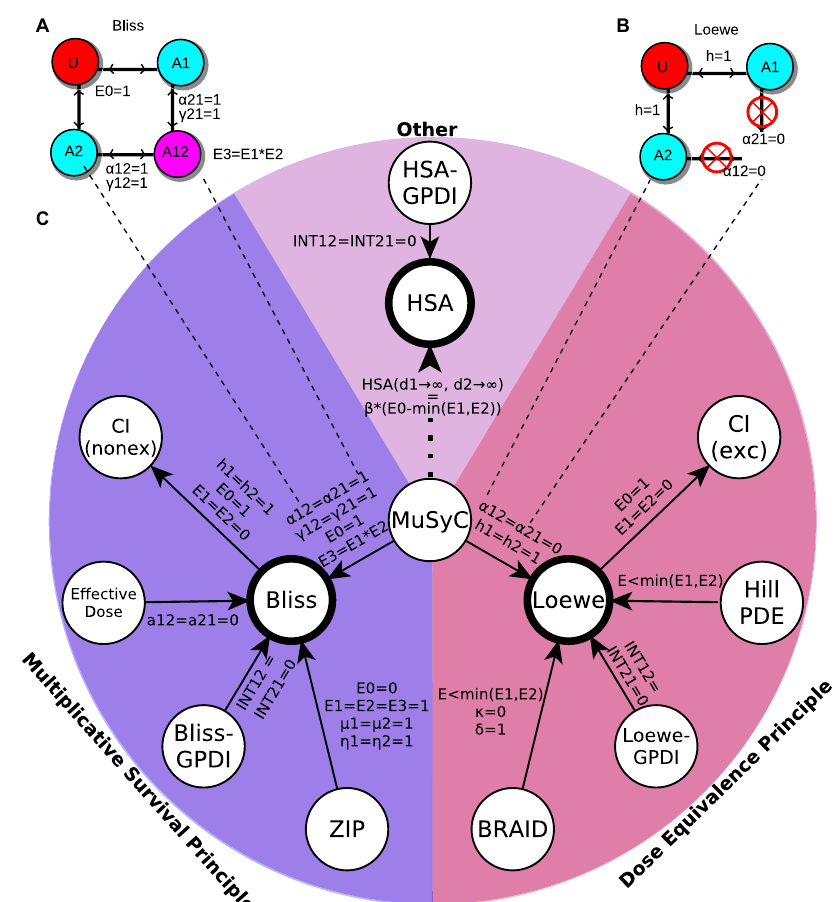
Fig. 2 Unifying MSP and DEP with MuSyC, and mapping the landscape of drug synergy. A The Bliss null model, the base model for all MSP frameworks, emerges from MuSyC when E 0 = 1, α 12 = α 21 = γ 12 = γ 21 = 1, and E 3 = E 1 E 2 . B The Loewe null model, the base model for all DEP frameworks, emerges from MuSyC when h 1 = h 2 = 1 and α 12 = α 21 = 0. The constraint on α indicates the drugs' activities are mutually exclusive (i.e., the double-drugged state A 1,2 does not exist). C Network of relationships between synergy frameworks (nodes) grouped by their underlying principle (colors). The notation next to solid edges signi fi es conditions under which source model reduces to end model ’ s null model. The dotted edge indicates MuSyC synergistic ef fi cacy ( β ) is proportional to HSA as d 1 → ∞ , d 2 → ∞ . See Supplemental Section Derivation of the theoretical relationships between different synergy frameworks for complete annotation of the parameters de fi ned in each method. Where possible, parameters from each framework were translated in terms of the dose- response parameters de fi ned for MuSyC (Table 1) to facilitate comparison. CI has two equations for synergy for the mutually exclusive (exc) and non- mutually exclusive (nonex) binding case. Conditions for which Bliss or Loewe reduces to the CI(nonex) and CI(ex) models were found in Chou and Talalay 34 . The mutually exclusive case is recommended by Chou 37 and used in the CompuSyn software. Likewise, GPDI has three separate equations for HSA, Bliss, and Loewe models. In contrast, MuSyC has one equation (Box 1, Eq. (15)) which reduces to Bliss and Loewe under certain